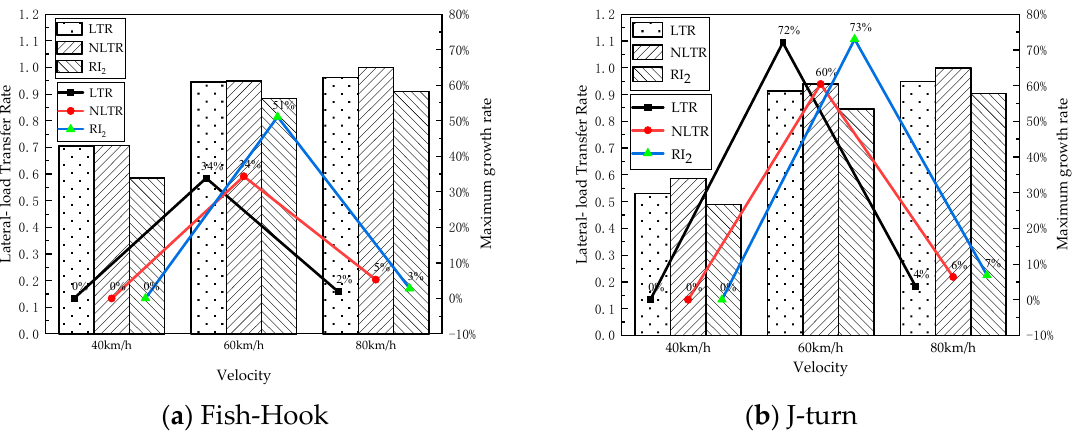
Figure 4. Comparison of three types of rollover indicators.